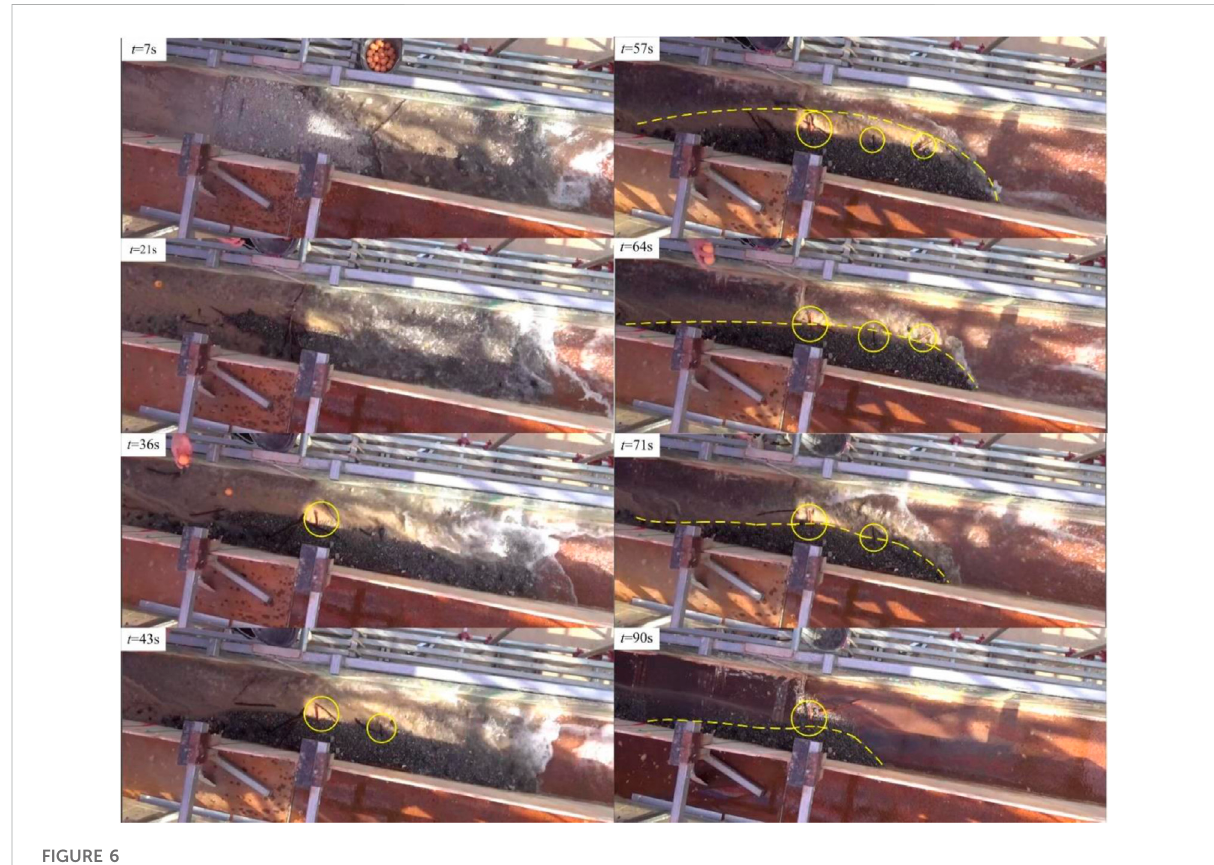
FIGURE 6 Initiation process of a woody debris fl